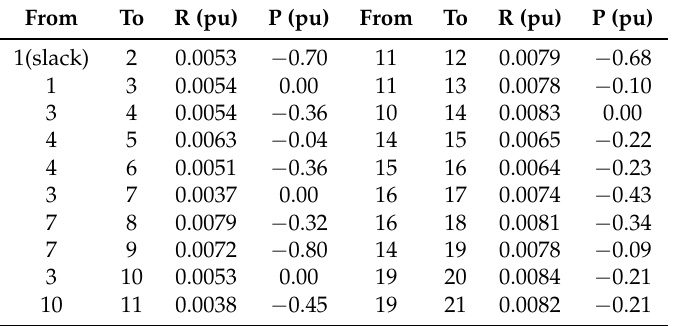
Table 2. Electrical parameters of the 21 bus test system.